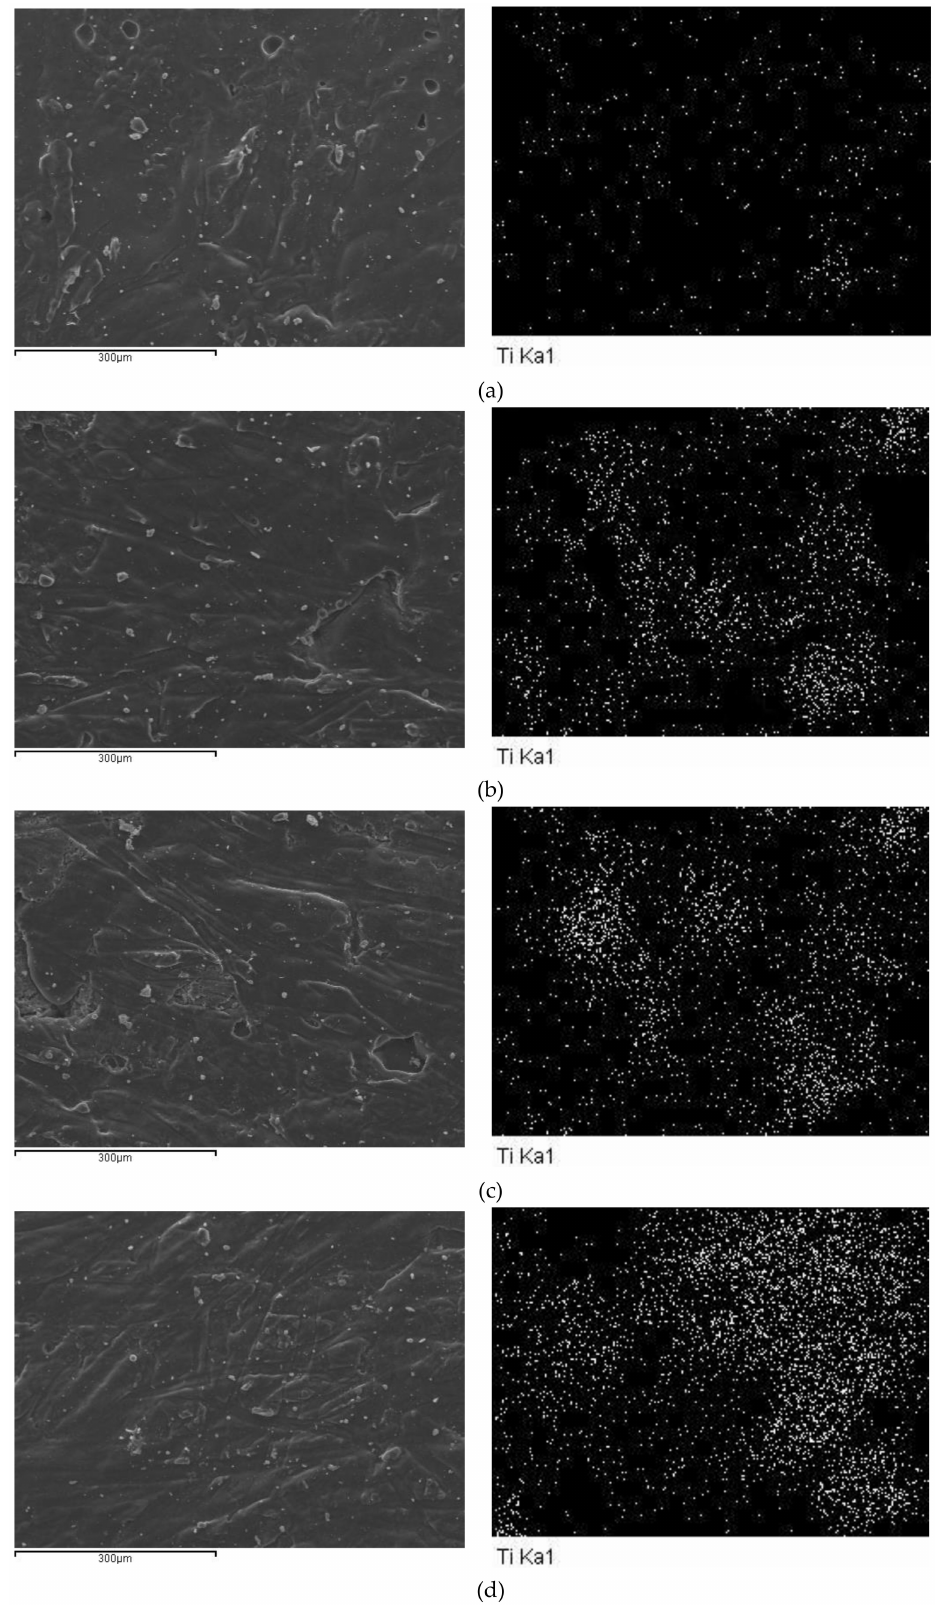
Figure 1. SEM micrographs and Ti mapping of ( a ) PEF/TiO 2 5%, ( b ) PEF/TiO 2 10%, ( c ) PEF/TiO 2 15%, and ( d ) PEF/TiO 2